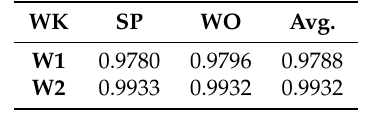
Table 9. F 1 accuracy of the walking group (WK).